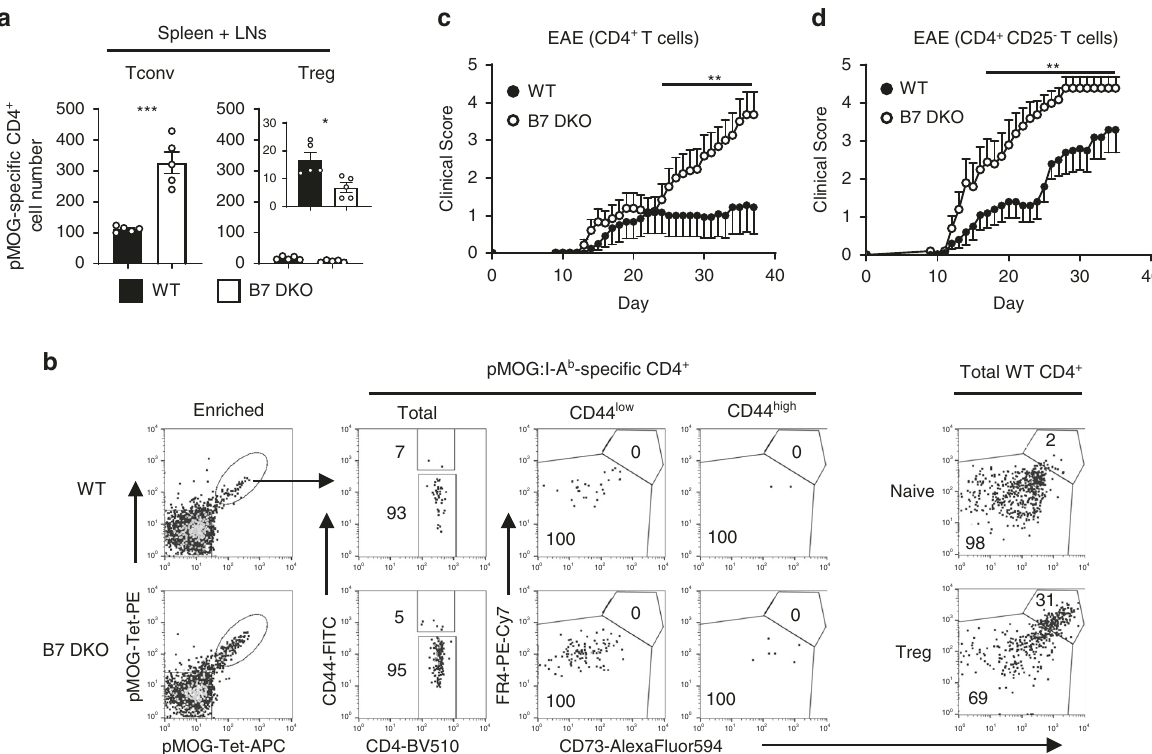
Fig. 4 Self-reactive CD4 + T cells capable of inducing autoimmune response accumulate in the periphery in the absence of B7-CD28 co-stimulation. a Peripheral pMOG-speci fi c CD4 + T cell number was increased in B7 DKO mice. Each group n = 5. Data shown are combined results of at least three independent experiments. Tconv p = 0.0002, Treg p = 0.0114. Data are mean ± SEM with dots representing individual values of biologically independent animals. Statistical differences between groups were calculated using unpaired, two-tailed Student ’ s t -test. b pMOG-speci fi c peripheral CD4 + T cells do not have an anergic phenotype. Each group n = 4. Data are a representative FACS plot of three independent experiments. c CD4 + T cells from B7 DKO mice strongly induced EAE. WT n = 12, B7 DKO n = 13 biologically independent animals. Data are pooled results of two independent experiments (mean ± SEM). p = 0.0089. Medians of the total clinical score during day 25 – 37 were compared by two-tailed non-parametric Mann – Whitney test. d